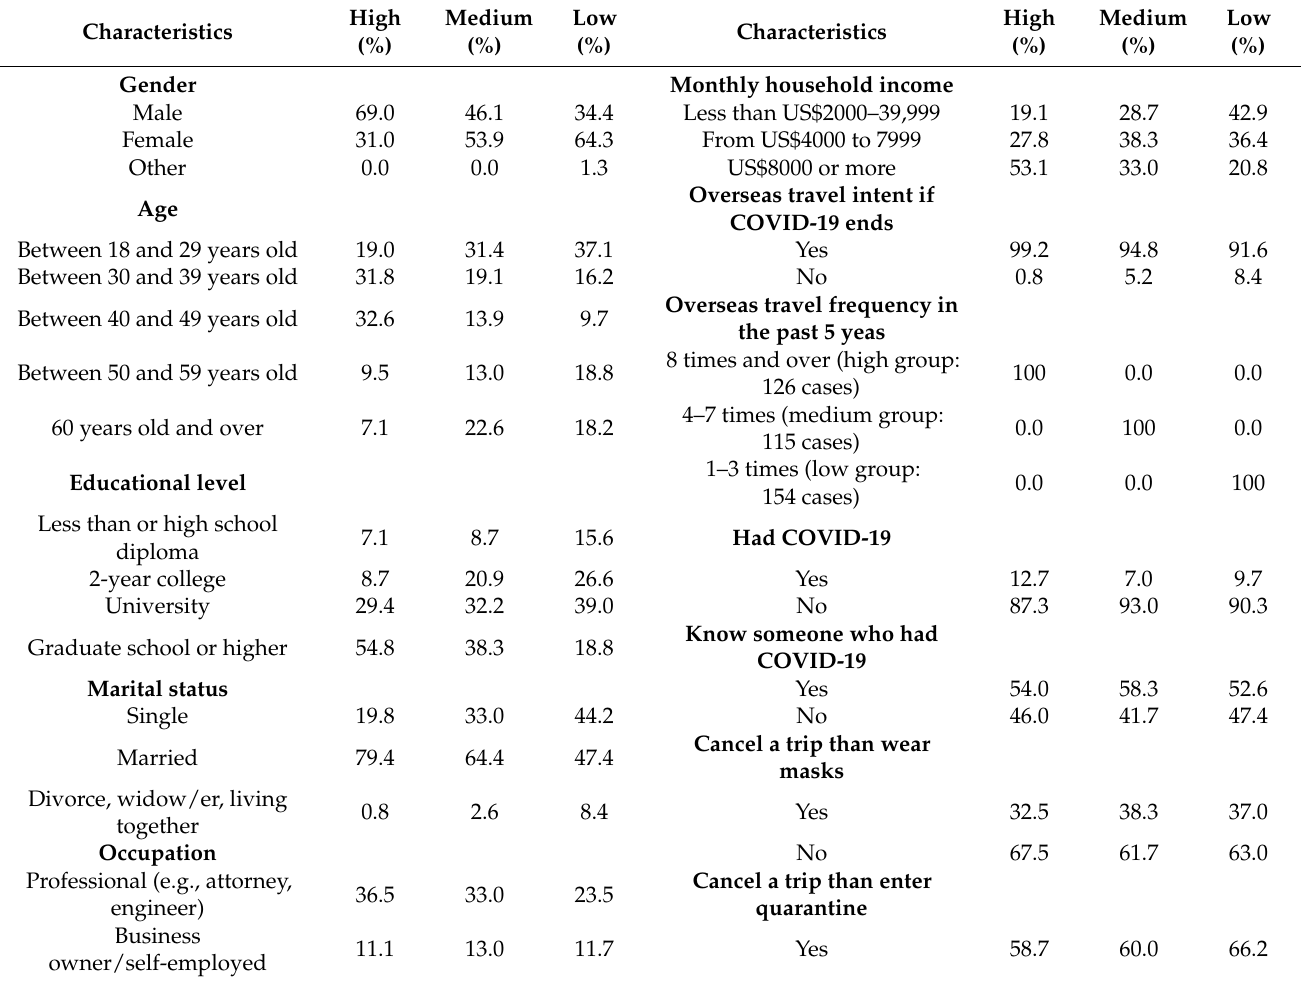
Table 2. Demographic characteristic of the high, medium, and low-frequency groups of international